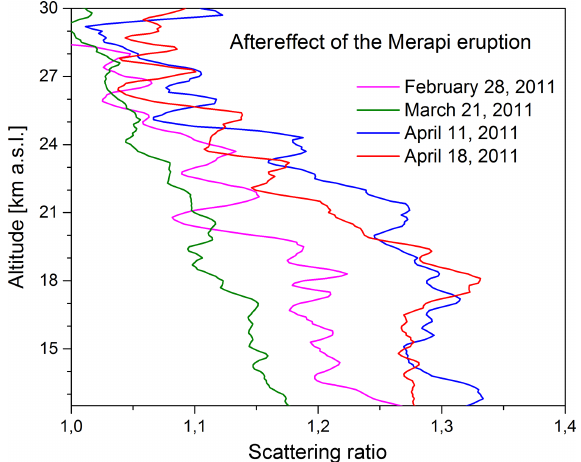
Figure 12. Perturbed scattering ratio profiles retrieved from the SLS aerosol lidar measurements in the winter–spring period of 2011.